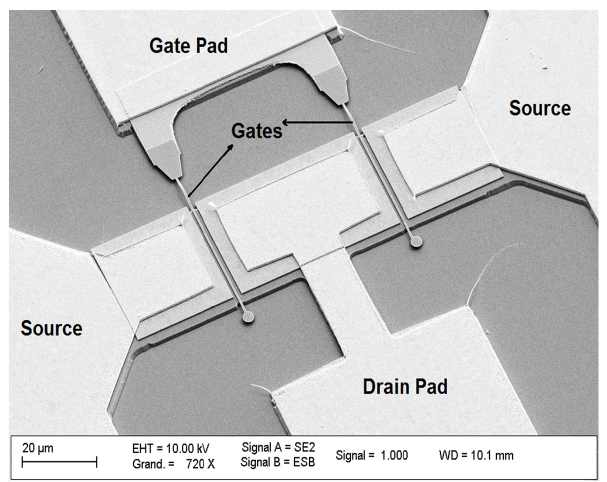
Figure 2. SEM image of In 0.53 Ga 0.47 As MOSFETs with two fingers.